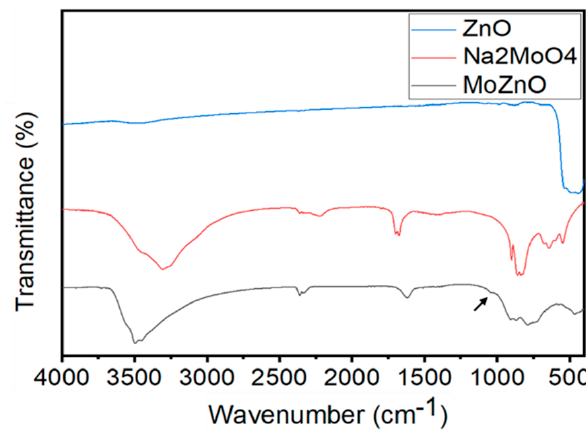
Figure 4. FT-IR spectra of ZnO, Na 2 MoO 4 · 2H 2 O, and MoZnO.